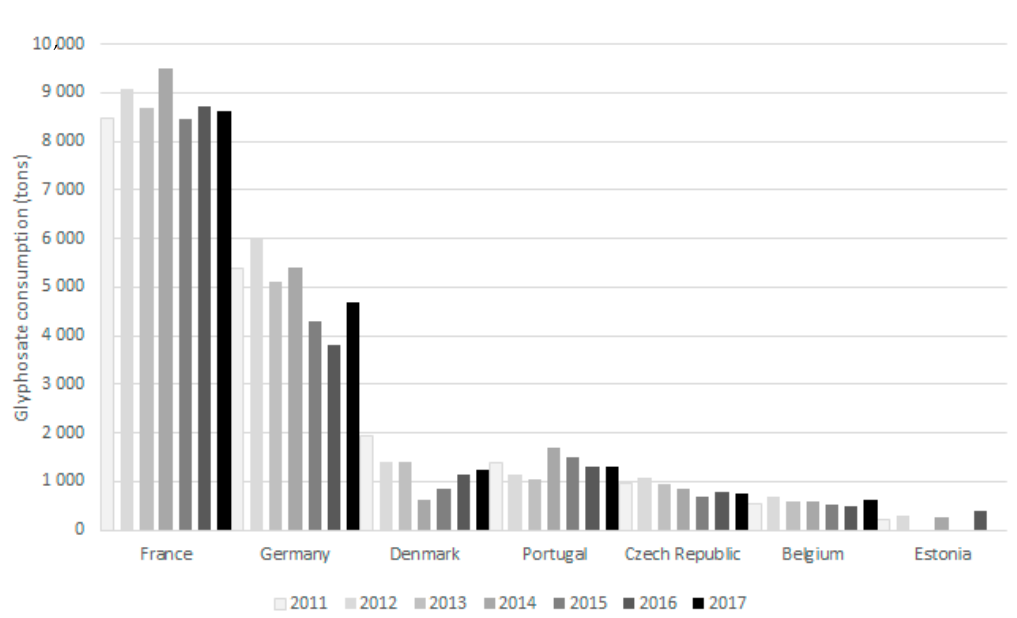
Figure 5. Glyphosate consumption in some European countries between 2011 and 2017.